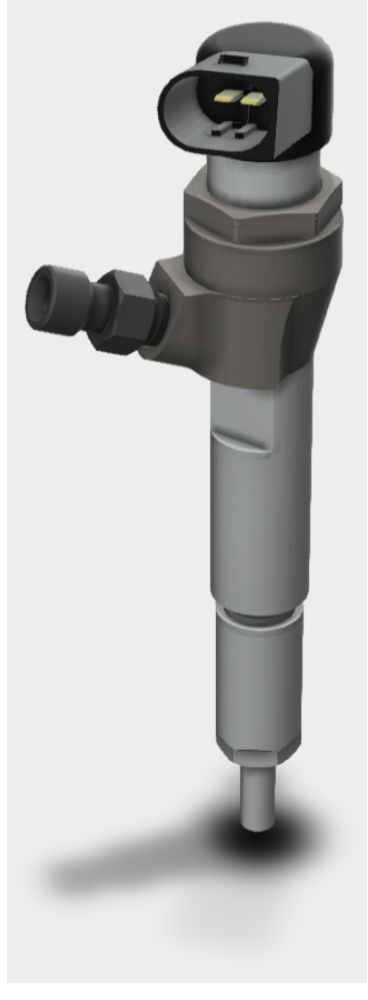
Figure 4. HPCR solenoid injector.